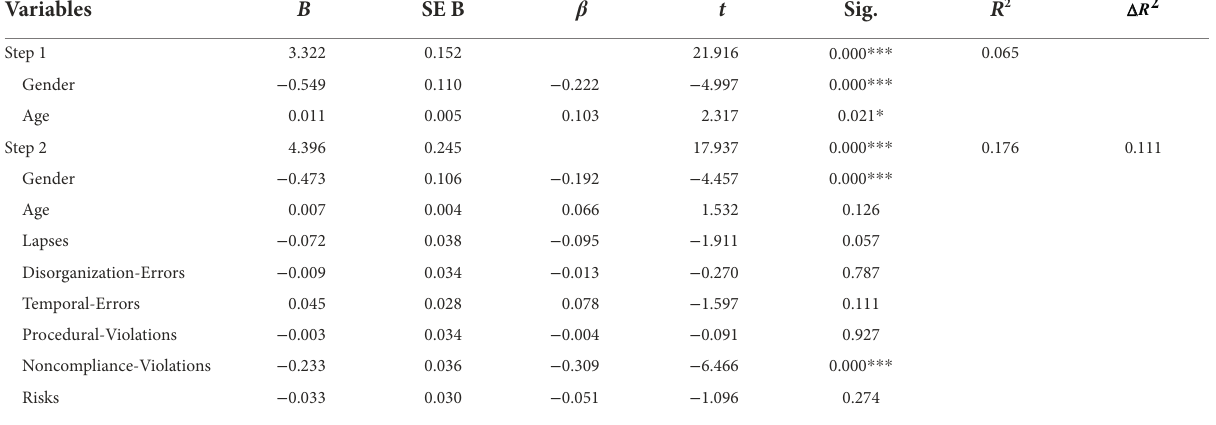
TABLE 5 Results of hierarchical multiple regressions for COVID-19 adherence behavior (Study 2).